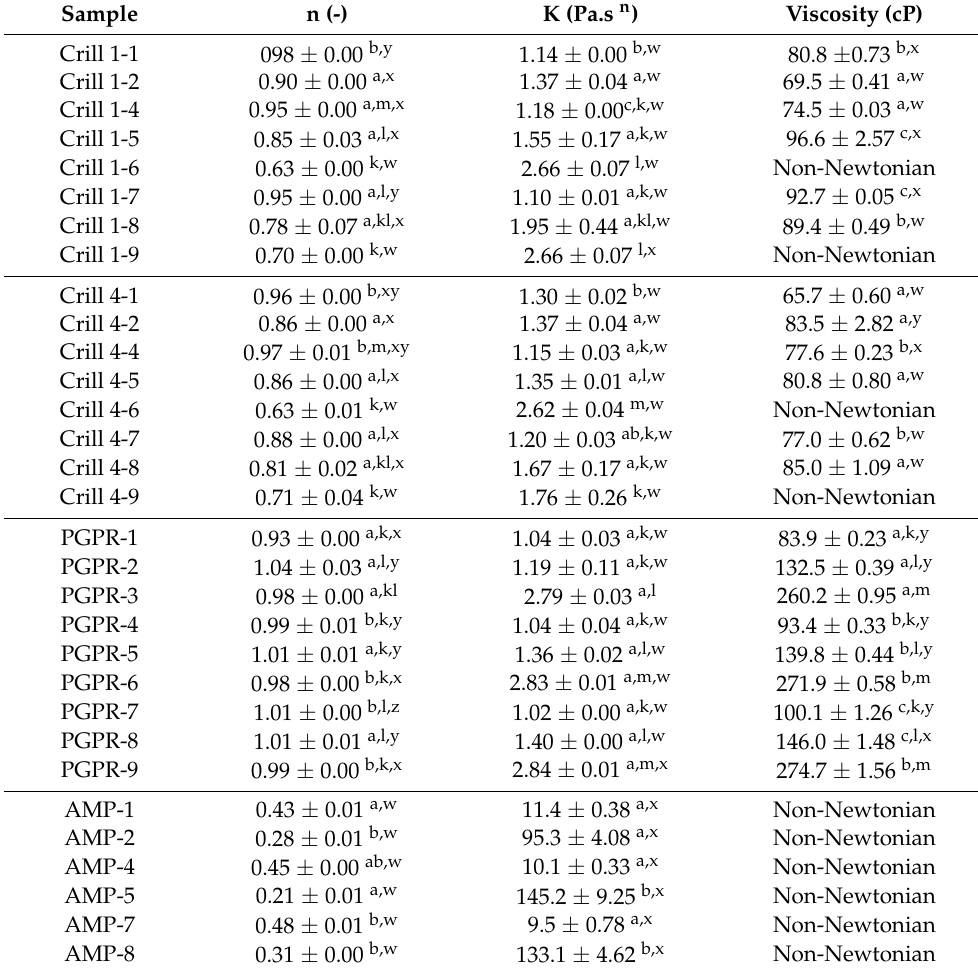
Table 2. Flow behaviors of W/O emulsions produced using different emulsifiers with various emulsifier concentrations and dispersed phase ratios